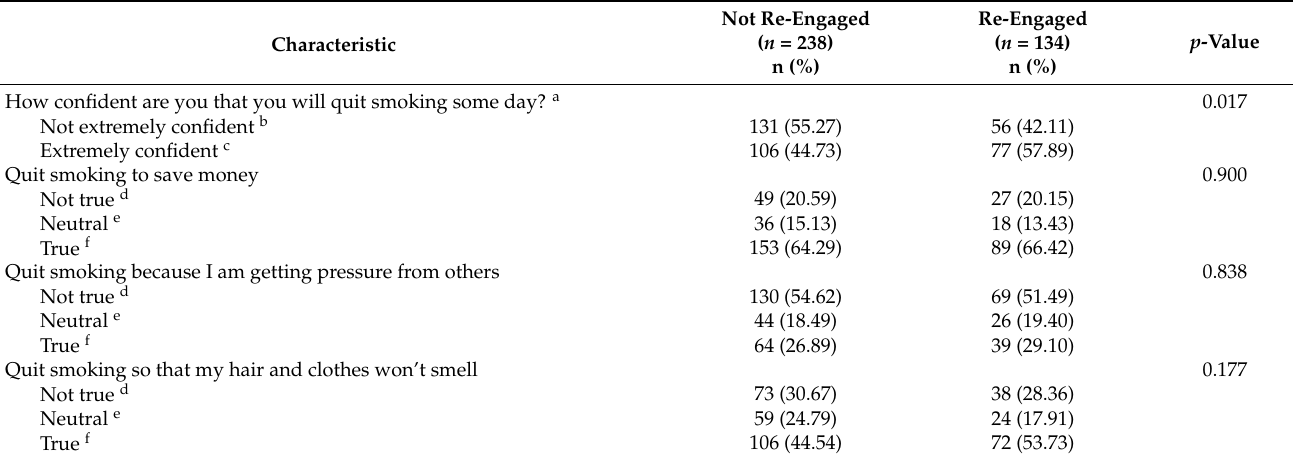
Table 2. Baseline confidence in quitting and reasons for quitting by three-month